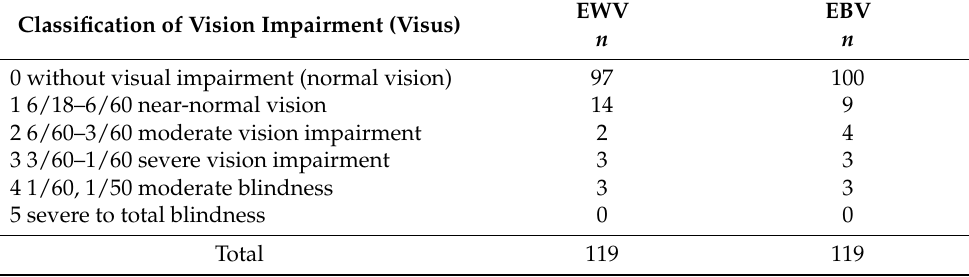
Table 2. Frequency of respondents within visual impairment (visus) categories. EWV: eye with worse vision; EBV: eye with better